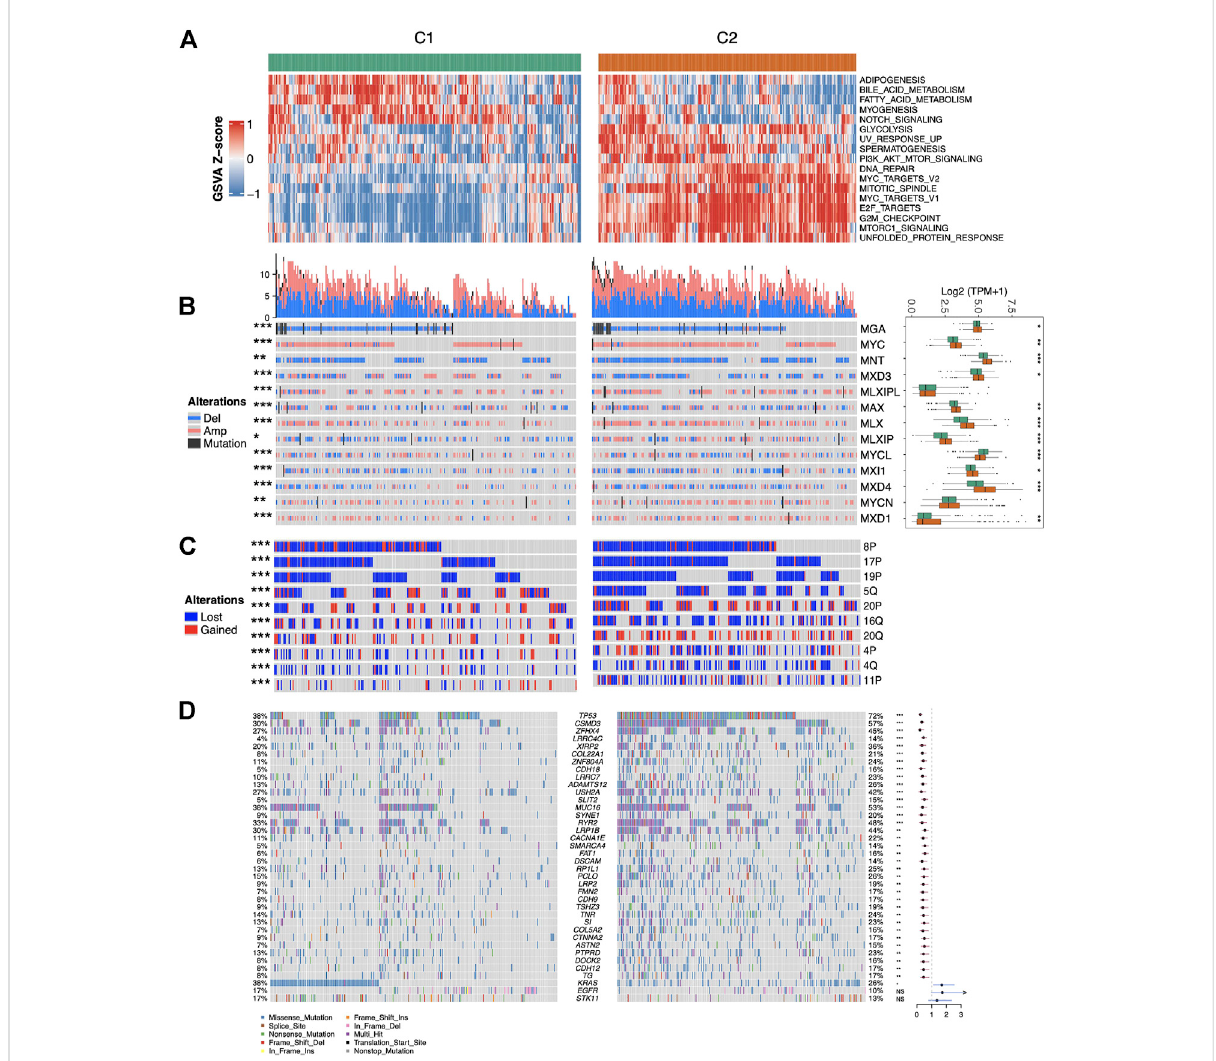
FIGURE 3 Association of MYC signaling with Hallmark pathways and genomic variations. (A) Heatmap of pathway scores with signi fi cant differences ( p < 0.001)betweenC1andC2. (B) Mutations,copynumbervariationsandexpressionofcoremembersoftheMYCpathwaybetweenC1andC2samples. (C) Variationattop10chromosomearmlevelswithsigni fi cantdifferencesbetweenC1andC2. (D) Waterfallplotshowingthedistributionofmutation characteristics of commonly mutated genes in the C1 and C2, and differently mutated genes between two groups by fi sher